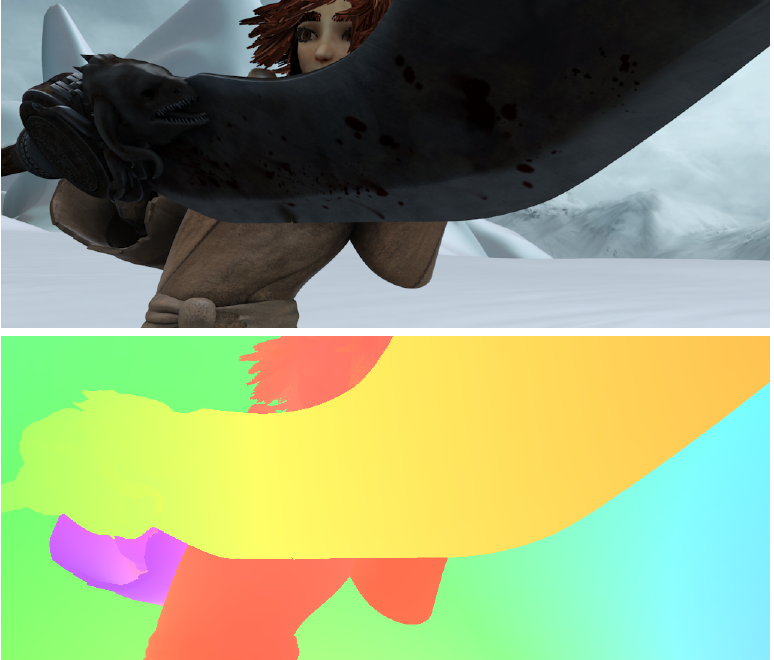
Figure 13. An example of an image ( up ) and its dense optical flow ground truth ( down ) from the MPI-Sintel final